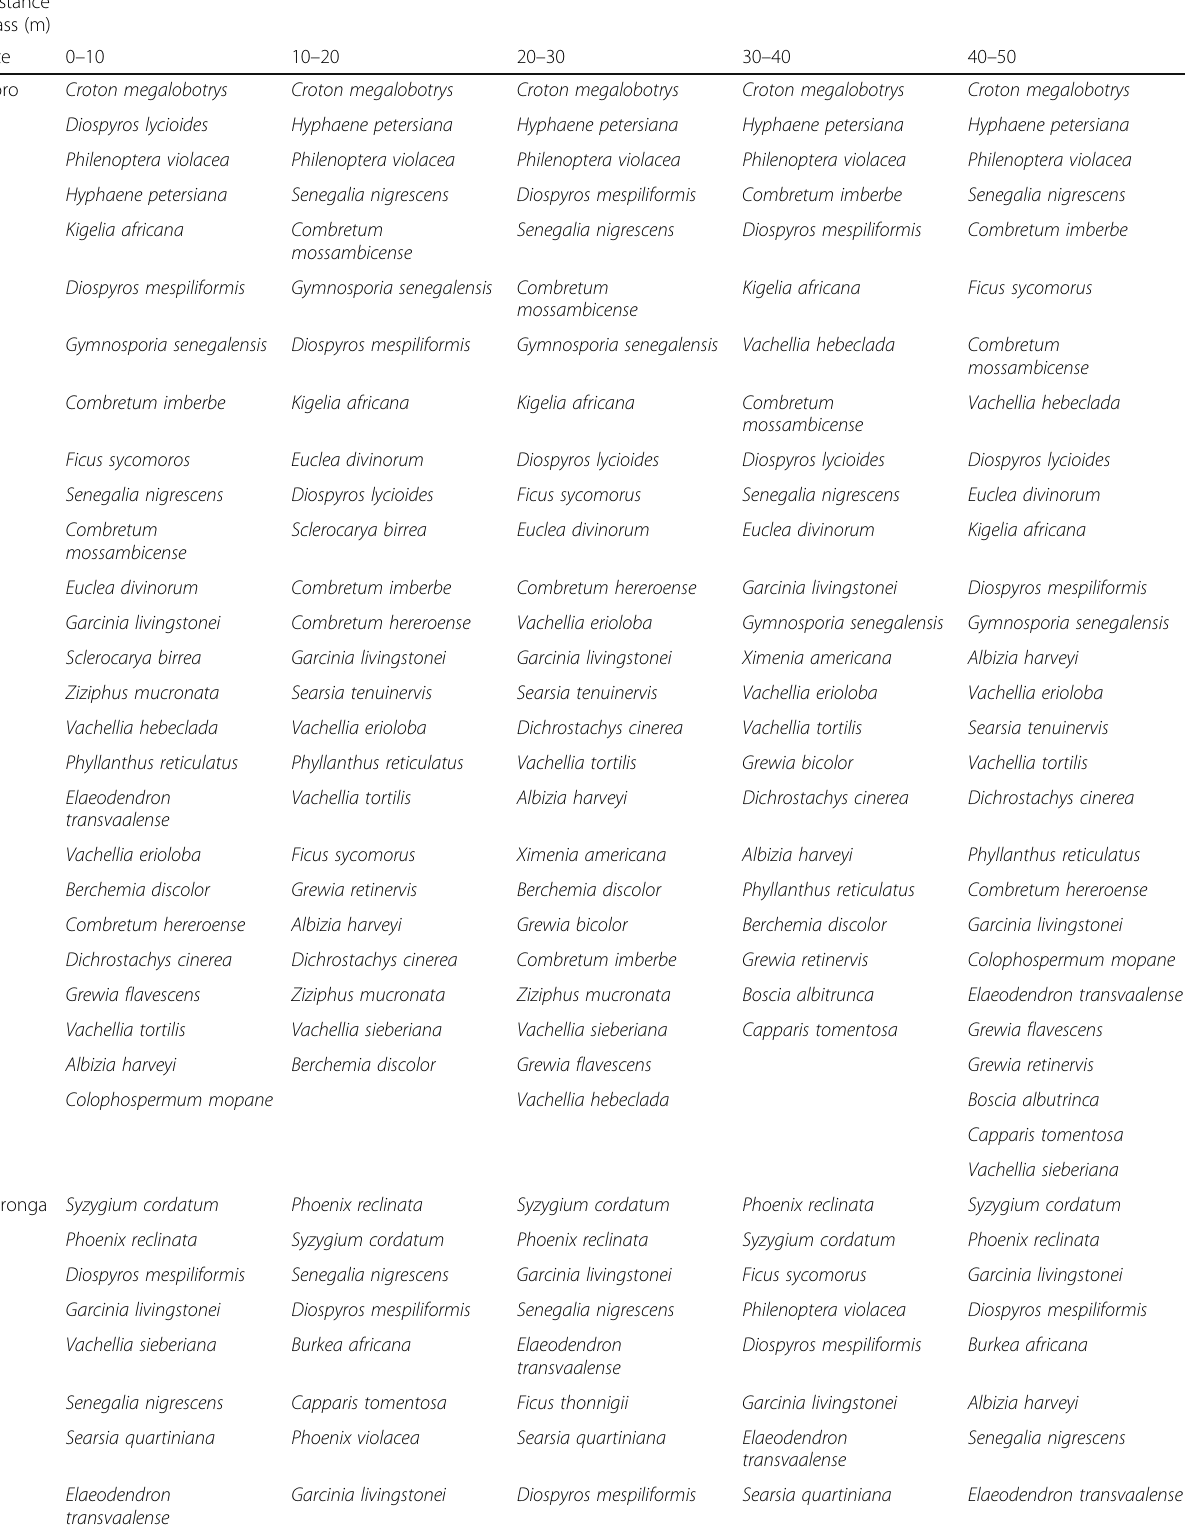
Table 2 Variation in composition of riparian woodland species at each distance class Distance class